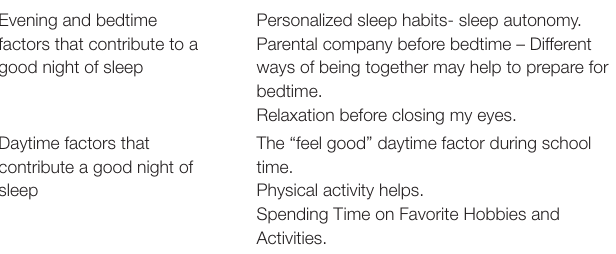
TABLE 4 | Overview of master themes and subthemes. Evening and bedtime Personalized sleep habits- sleep autonomy. factors that contribute to a Parental company before bedtime – good night of sleep